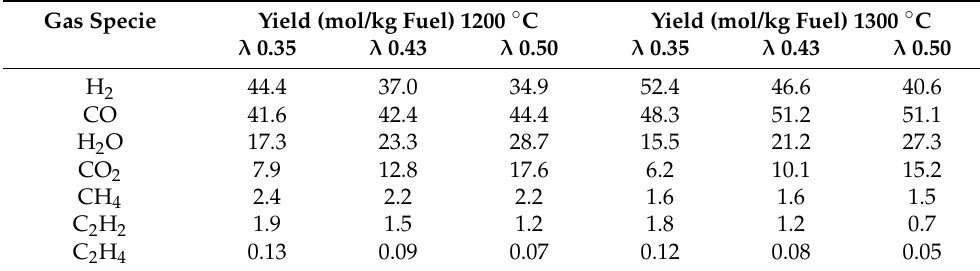
Figure 1. Total ion gas chromatograms of liquid (above) and wax (below) from PP pyrolysis at 600 ◦ C. Peak identifications: C 6 2-methyl-1-pentene; C 9 2,4-dimethyl-1-heptene; C 10 2,4,6-trimethyl-1-heptene; C’ 10 2,4,6-trimethyl-1,6-heptadiene; C 11 4,6-dimethyl-2-nonene (meso form); C 12 2,4,6-trimethyl-1-nonene (meso form) and 2,4,6-trimethyl -1-nonene (racemic form); C 13 2,4,6,8-tetramethyl-1-nonene (meso form); C’ 13 2,4,6,8-tetramethyl-1,8-nonadiene (meso form); C 15 2,4,6,8-tetramethyl- 1-undecene (isotactic), 2,4,6,8- tetramethyl-1-undecene (heterotactic) and 2,4,6,8-tetramethyl-1-undecene (syndiotactic); C 16 2,4,6,8,10-pentamethyl-1-undecene (isotactic); C’ 16 2,4,6,8,10-pentamethyl-1,10-undecadiene (isotactic); C 18 2,4,6,8,10- pentamethyl-1-tridecene (isotactic); C’ 19 2,4,6,8,10,12-hexamethyl-1,12-tridecadiene (isotactic); hydrocarbons series from i-C’ 21 to i-C’ 46 . Table 4. Yield of gas components (mol/kg fuel) from gasification experiments at different operat- ing